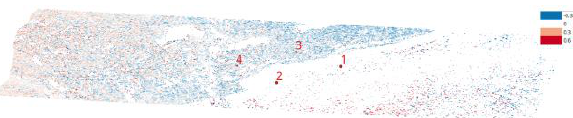
Figure 10. Descending track-Sept.11-22: Points after filtration and thresholding, (Hlaváčová,